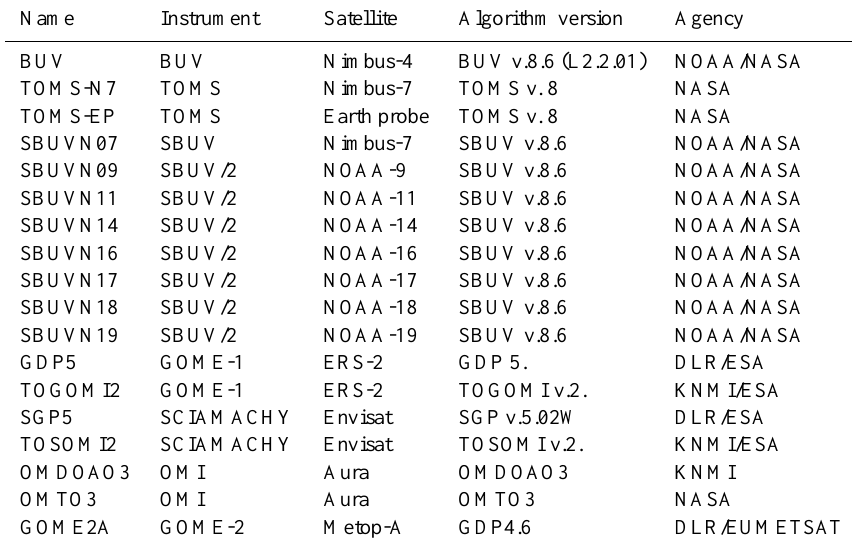
Table A2. The satellite data sets used in this study. The columns show the name of the data set, the satellite instrument on which it is based, the satellite, the algorithm version used and the responsible agency for this data